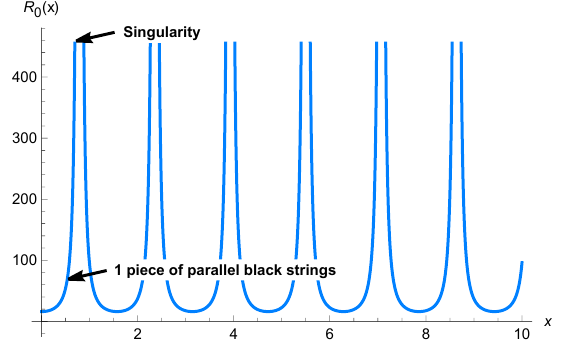
Figure 5 . We only pick one of black string solutions, the singularities locate at n π